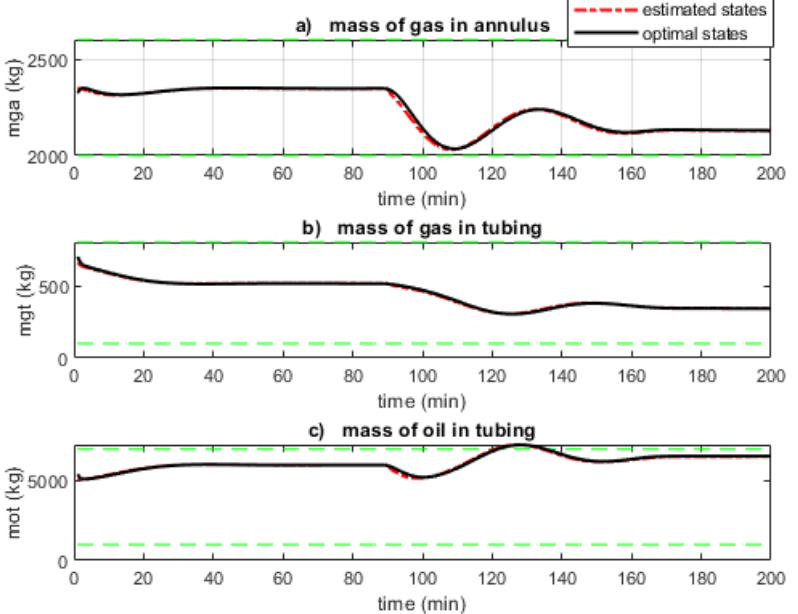
Figure 9. The states of the gas lift system when the desired input ( u des ) switches from the input bound to out of the input bound. The state’s bounds are still